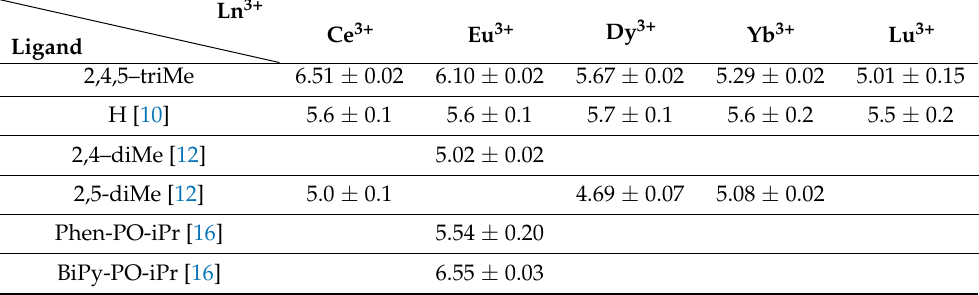
Table 1. Stability values of complexes (logβ 1 ) of trivalent lanthanide ions with 2,3,4-triMe diamide in comparison with 2,4-diMe and unsubstituted diamide in acetonitrile and N,PO tetradentate ligands. Ln 3+